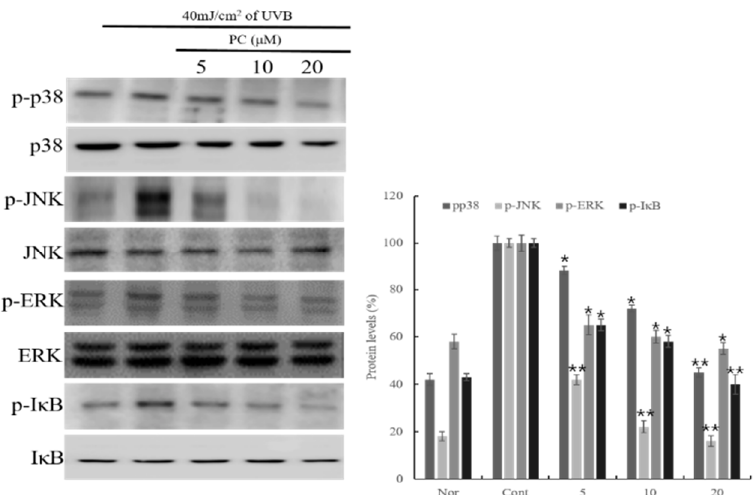
Figure 4. E ff ect of PC (1) treatment on MAPK expression in HaCaT cells. HaCaT cells were pre-treated di ff erent concentrations of PC (1) (5, 10, 20 µ M) for 1 h. The cells were further stimulated with 40 mJ / cm 2 UVB. After 6 h, the cells were harvested, and the relative protein levels were determined. Histograms show the densitometric data of p-p38, p-JNK, p-ERK, and p-I κ B protein normalized to GAPDH. Each value represents the mean ± SD of three individual experiments. Nor: Non-treated cell group (0 h), Cont: 40 mJ / cm 2 UVB-treated cell group. Data are expressed as the means ± S.D., n = 3. * p < 0.001 and ** p < 0.0001 compared to the control